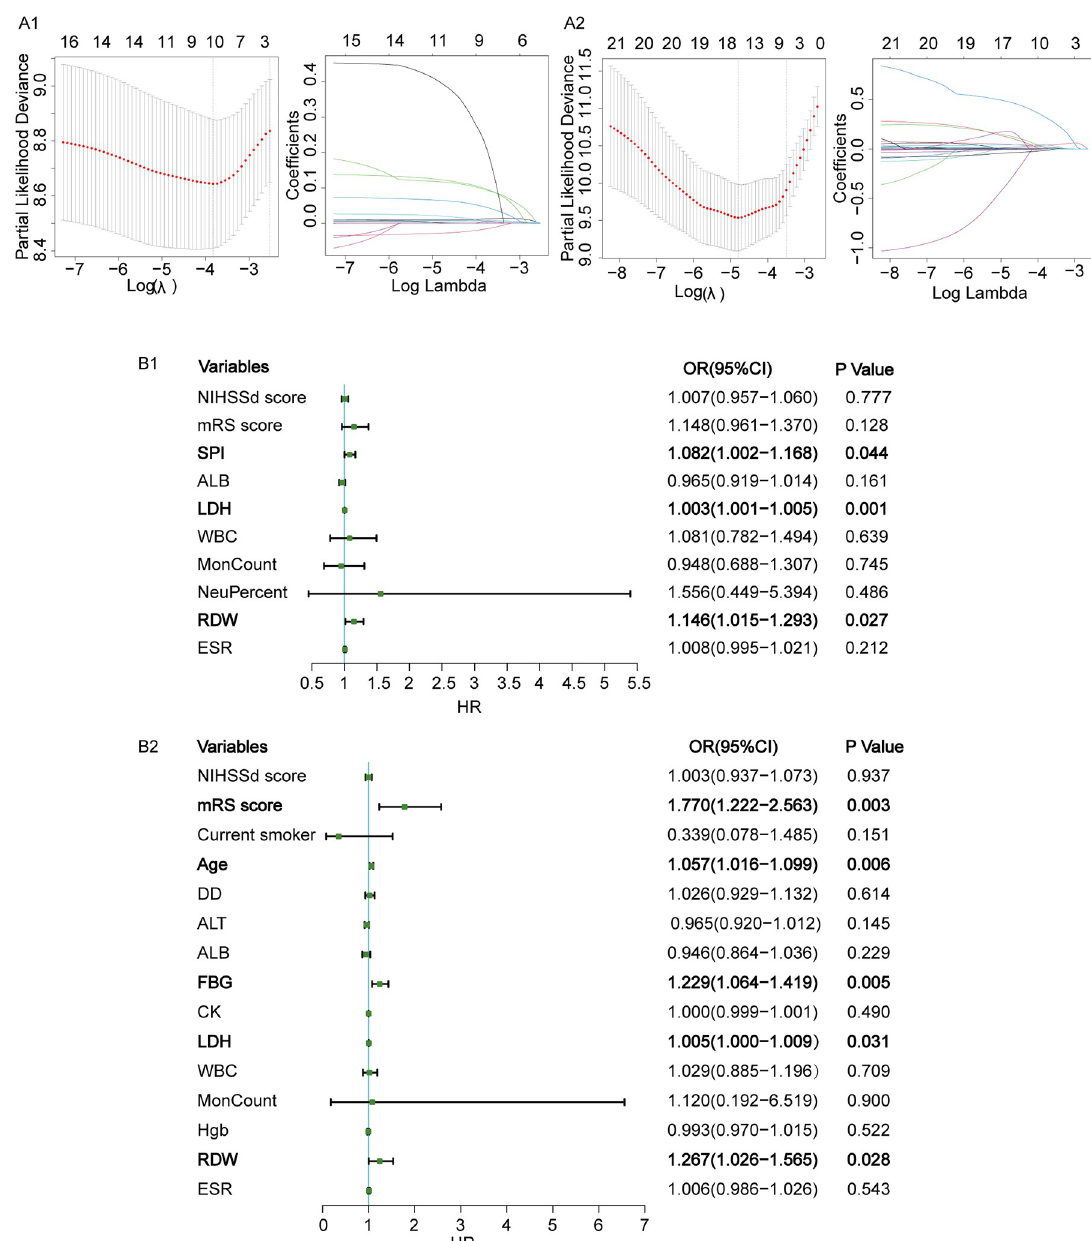
Fig 3. The LASSO Cox proportional hazard regression and forest map of Cox proportional hazard regression for prognosis and all-cause death in patients with AIS. A1. LASSO Cox proportional hazard regression for prognosis in patients with AIS; A2. LASSO Cox proportional hazard regression for all-cause death in patients with AIS; B1. Forest map of Cox proportional hazard regression for prognosis in patients with AIS; B2. Forest map of Cox proportional hazard regression for all-cause death in patients with